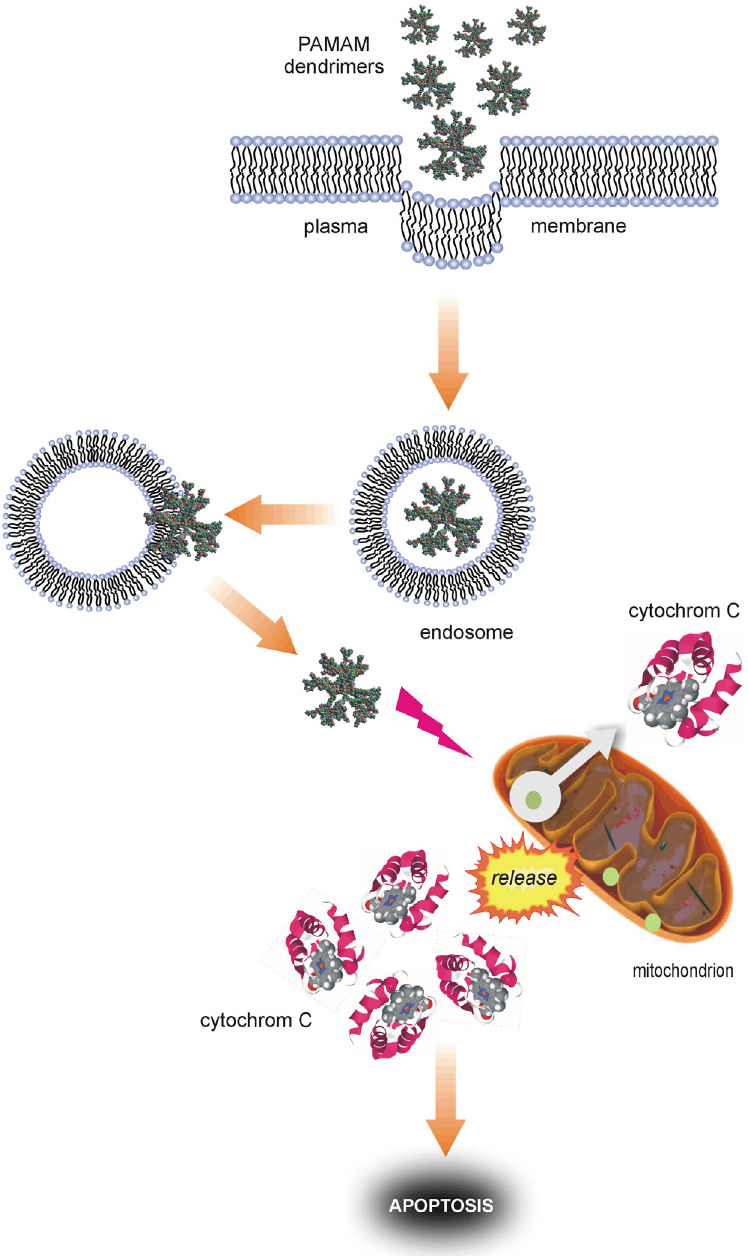
Figure 10. Possible mechanisms of the pro-apoptotic activity of PAMAM